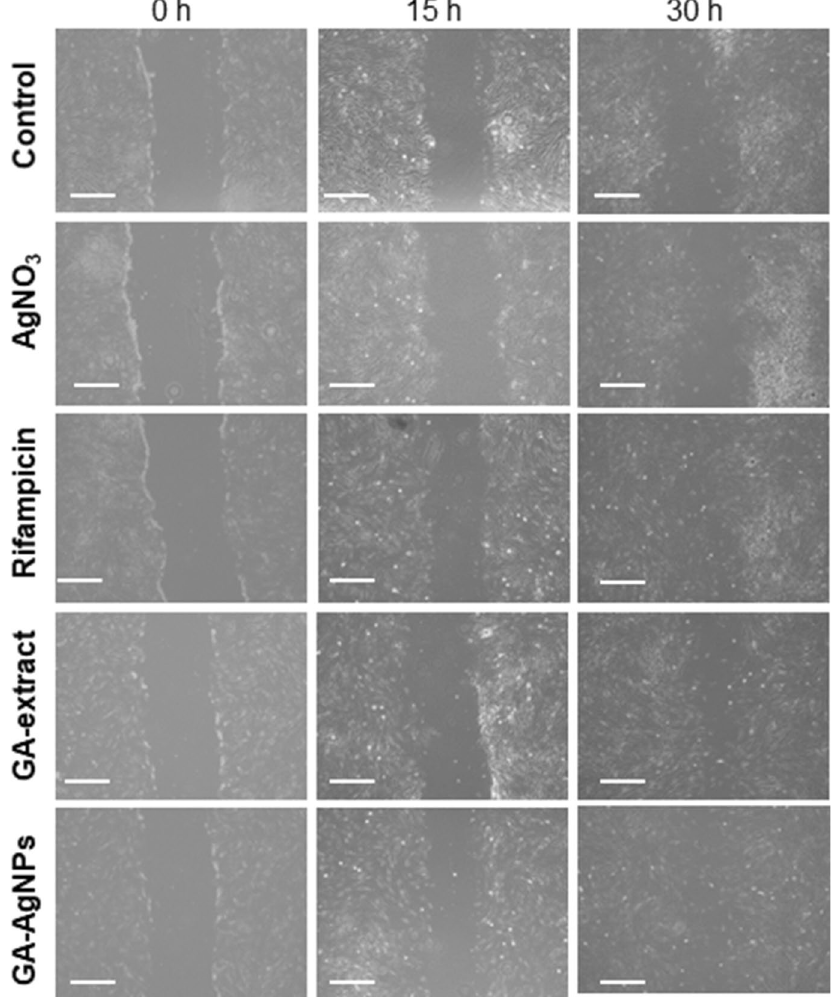
Figure 7. Wound healing effect of GA-AgNPs in cell scratch assay: at 0 h, 15 h and 30 h (×10 magnification) using human dermal fibroblast, (scale bar: 200